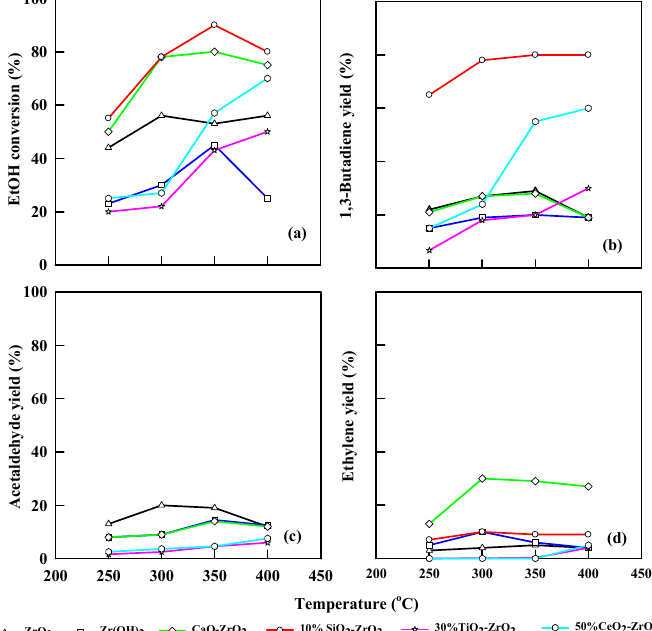
Figure 7. Plot of ethanol conversion ( a ), yields of 1,3-butadiene ( b ), acetaldehyde ( c ), and ethylene ( d ) vs. reaction temperature for different modified commercial catalysts. WHSV: 6.0 h − 1 , catalyst: 0.4 g, N 2 : 30 mL/min.